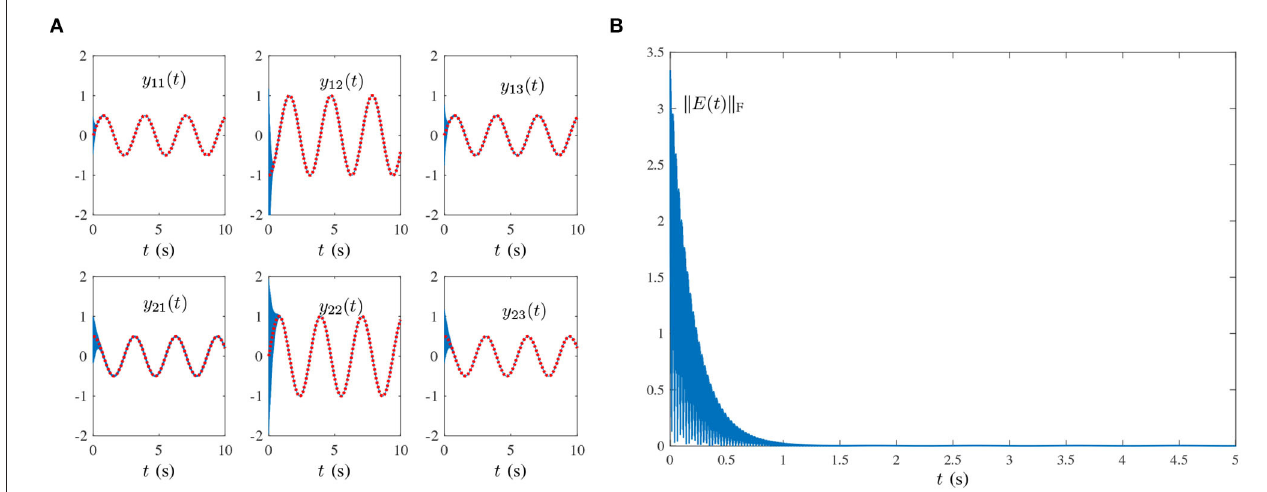
FIGURE 6 | Results synthesized by the HNTZNN model (14) using τ = 10 and λ = 1 for computing the pseudoinverse of the dynamic matrix (21) under the multiple-harmonic noise with an aperiodic characteristic. (A) State trajectory. (B) Residual error.